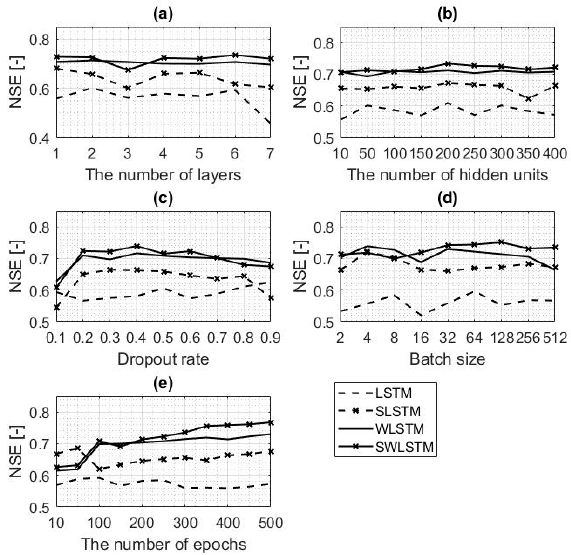
Figure 7. The effects of hyper-parameters, ( a ) the number of layers, ( b ) the number of hidden units,